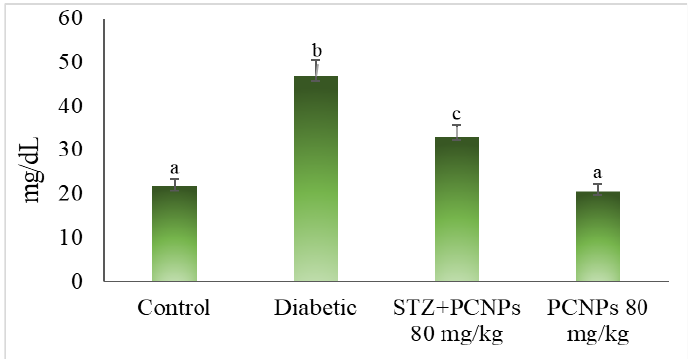
Figure 5. Activities of PCNPs on urea of experimental and control group. Values are mean ± SD for six rats at p < 0.05 (DMRT). a PCNPs alone treated group compared with control group. b Diabetic group compared with control group. c Treatment group compared with diabetic control.